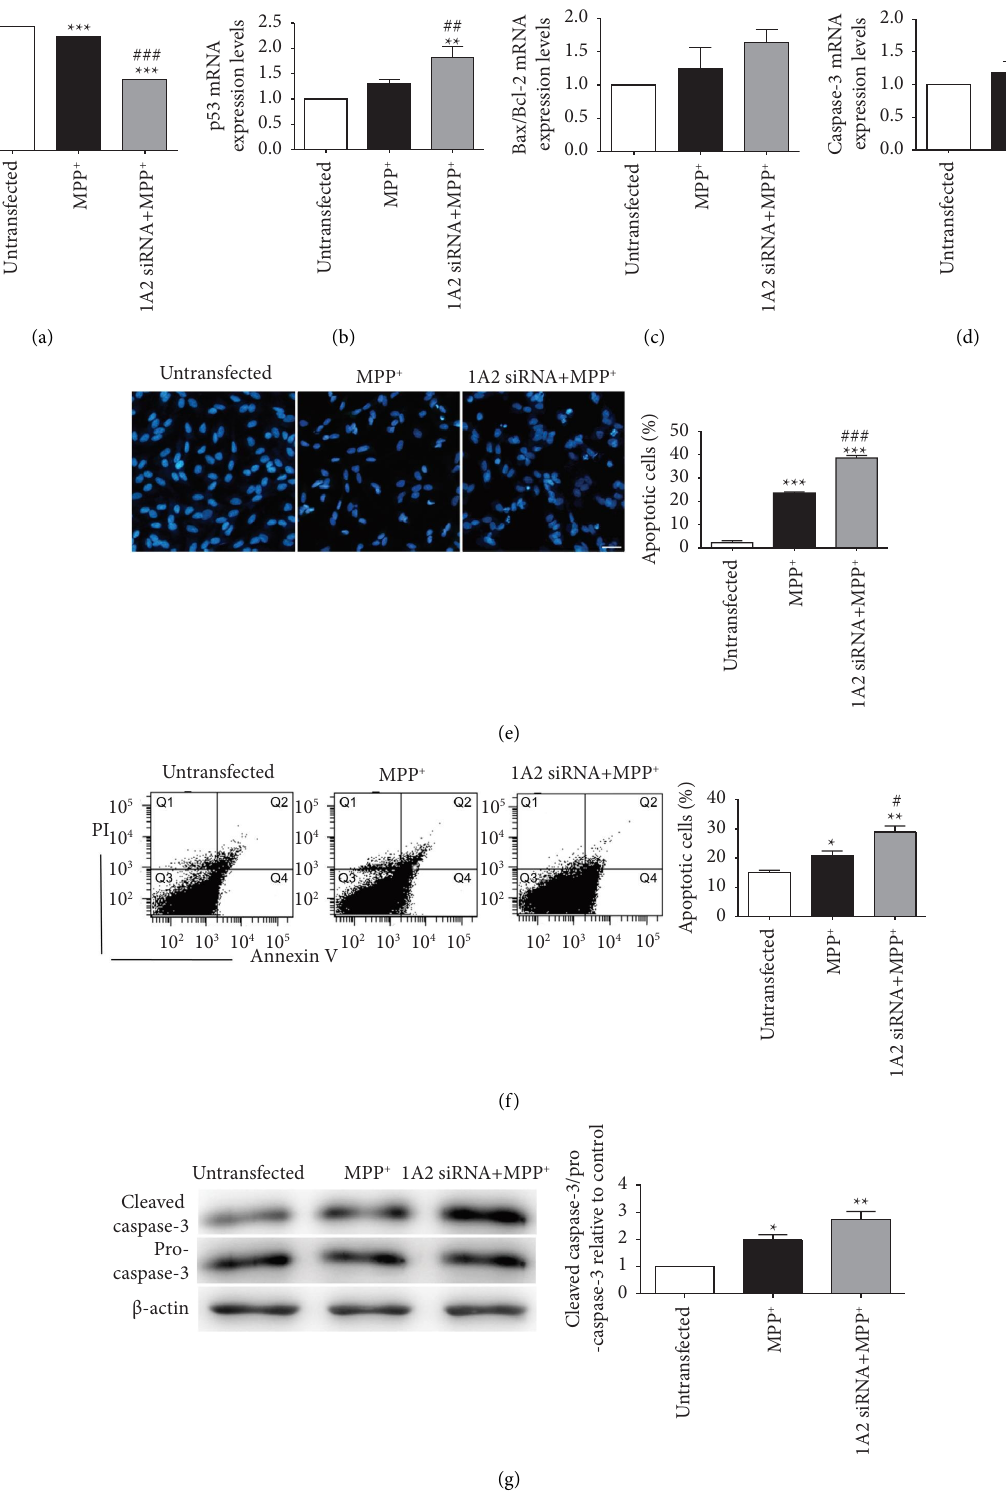
Figure 3: Efects of eEF1A2 knockdown on apoptosis induced by MPP + in SH-SY5Y neuronal cells. (a) Cell viability using an MTTassay. (b–d) Expression of p53, Bax/Bcl-2 ratio, and caspase-3 using quantitative real-time PCR. Te expression levels of the mRNAs were normalized to the expression level of β -actin. (e) Apoptotic nuclear morphology observed using Hoechst 33258 staining. Scale bar � 30 µ m. Graph represents the percentage of cells with apoptotic nuclei. (f) Graphs represent the percentage of Annexin V-positive cells obtained by Annexin V/PI fow cytometry. (g) Graph represents the relative ratio of cleaved caspase-3 to procaspase-3 protein expression obtained from Western blot assay. Te density of the bands was normalized with that of β -actin protein. Data are represented as mean ± SEM from three experiments with triplicates each. ∗ p < 0 . 05, ∗∗ p < 0 . 01, and ∗∗∗ p < 0 . 001 versus untransfected control; # p < 0 . 05, ## p < 0 . 01, and ### p < 0 . 001 versus MPP + treatment alone. 1A2,